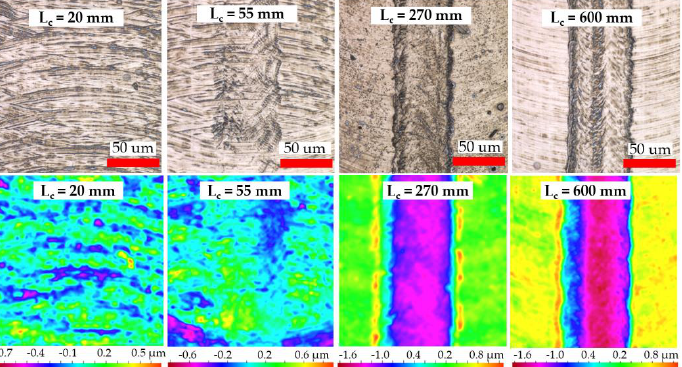
Figure 12. Micrographs and contour plots showing progression of material ploughing and depth of grooving for slots machined in Test 5. v f = 25 mm/min, f z = 0.156 µm/tooth.